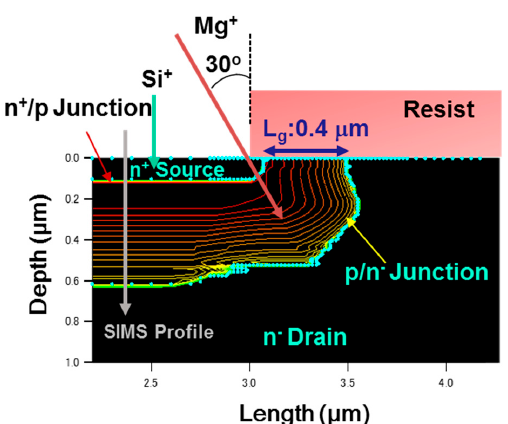
Figure 6. Ion-implanted Mg and Si profiles in a free-standing GaN substrate. Si background concentration in the substrate was about 5 × 10 16 cm − 3 .